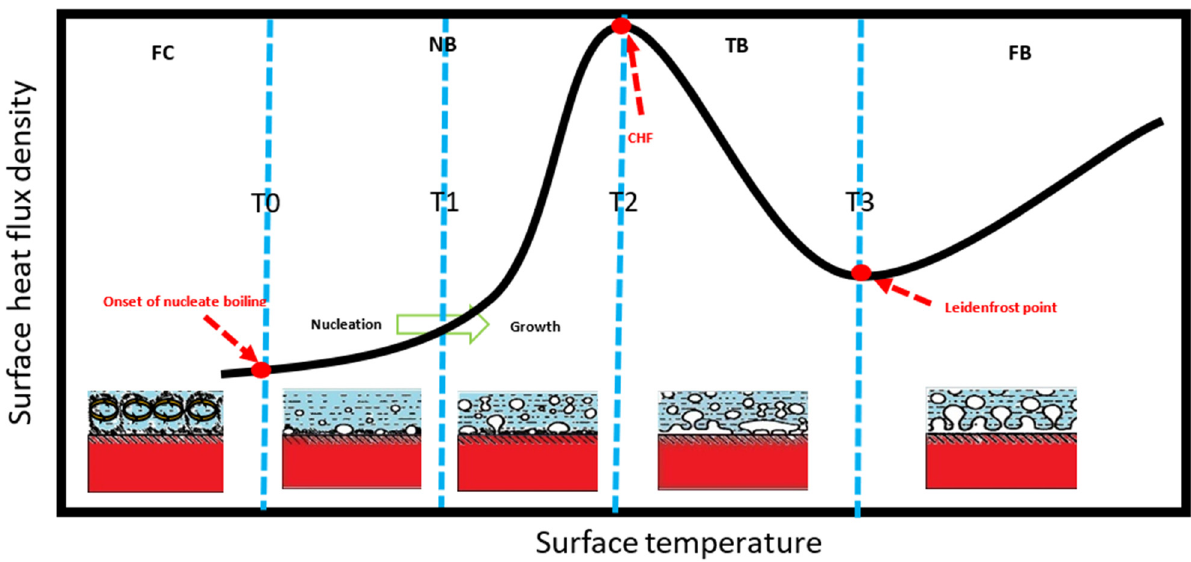
Figure 3. Typical pool boiling curve of surface heat flux density vs. surface temperature at various stages.